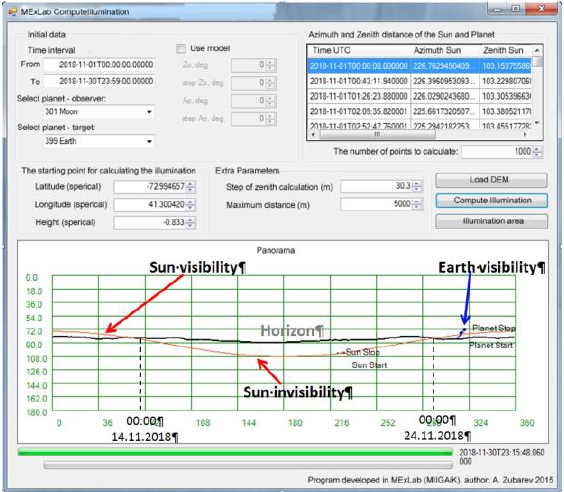
Figure 11. User interface of the ComputeIllumination module with results of Sun illumination and Earth visibility modelling for proposed candidate landing sites of future Russian mission Luna-Glob within crater Boguslawsky (72.9° S, 41.3° E).